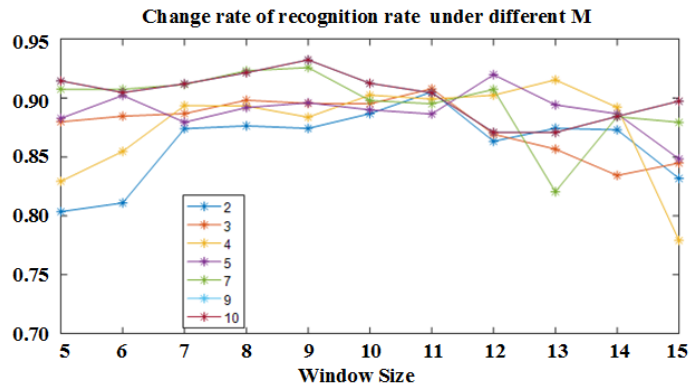
Figure 12. Change rate of recognition rate with sliding window under different